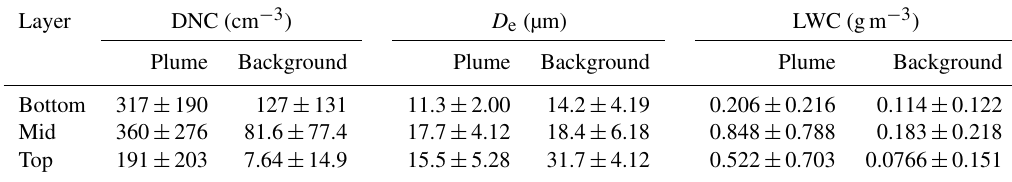
Table 2. Averaged bulk DSD properties for the three warm-phase layers and the respective standard deviations. The bottom layer is defined by relative altitudes between 0 and 20%, the middle layer between 20 and 50%, and the top between 50 and 100%.